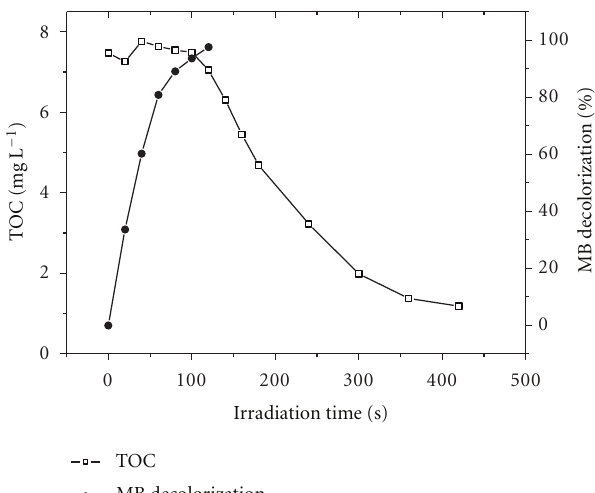
Figure 5: The TOC removal and decolorization e ffi ciencies versus irradiation time. (Experimental conditions: photon flux 3.13 × 10 − 6 einstein cm − 2 s − 1 ; TiO 2 , 0.01 gL − 1 ; MB initial concentration 20mgL − 1